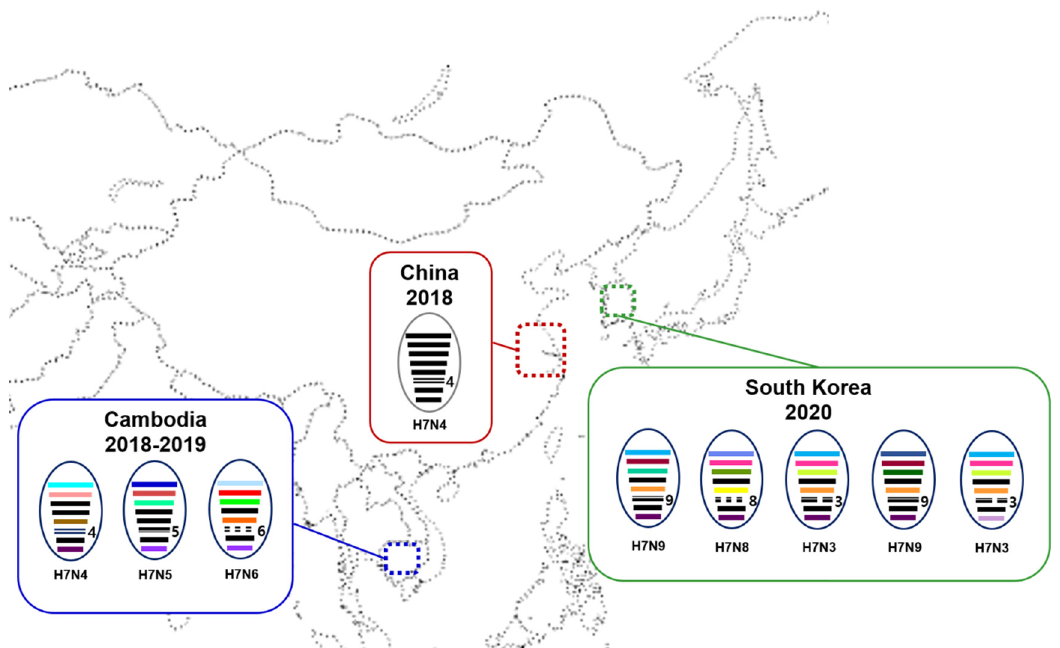
Figure 2. Schematic diagram of genomic compositions of the Jiangsu–Cambodian H7Nx viruses in East Asia. Each oval represents a viral isolate, within which the eight gene segments (from top to bottom: PB2, PB1, PA, HA, NP, NA, M, and NS) are indicated by horizontal bars. The color of each bar identifies its origin. Jiangsu province in China is indicated by red dotted box. The Cambodia and South Korea are indicated by blue and green dotted box, respectively.